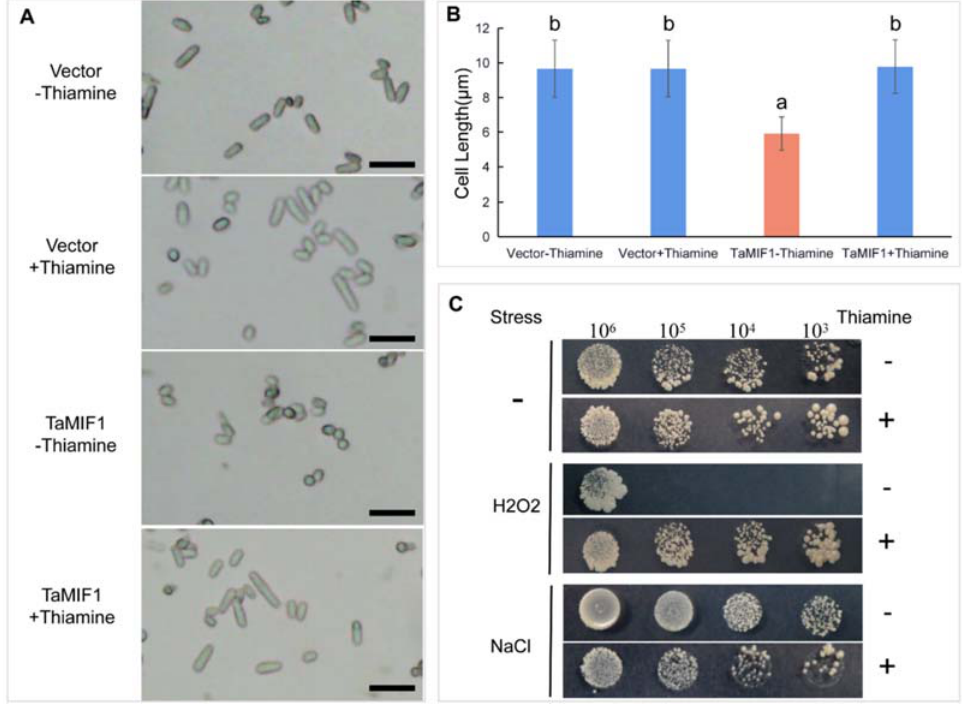
Figure 5. Effects of overexpressing Ta MIF1 in yeast. ( A ) TaMIF1 expressed in yeast could affect cell length. Yeast cells were observed under a microscope in bright field. Bars = 20 μ m. ( B ) The length of yeast cells were calculated. Differences were assessed using ANOVA with results from three replicates. ( C ) TaMIF1 expressed in yeast increased sensibility of yeast cells to oxidative stress. Yeast cells expressing TaMIF1 were grown on yeast medium containing 0.5 mM H 2 O 2 or 0.35 M NaCl.